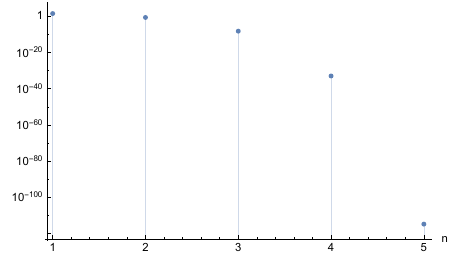
Figure 2. Error history for solving the integral equation in Example 2 using PM (Performed by